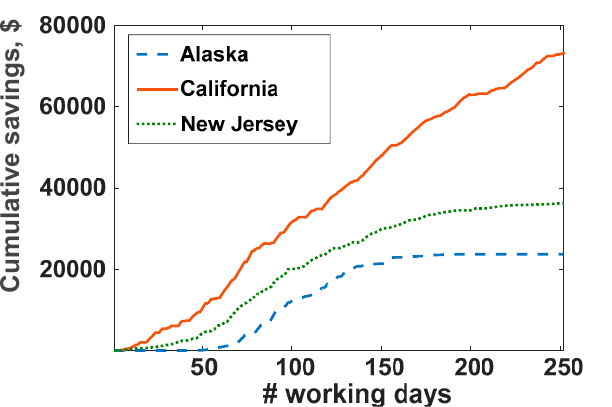
Figure 7 The original power balance profile and its change after different number of participating EVs. The curve 252 veh corresponds to the maximum total daily number of EVs awarded by a contract; the curve 150 veh is for illustration purposes to show the results of partial exploitation with less EVs than the prosumer needs to dispose its PV energy excess. In the case of no collaboration with EVs, the prosumer will at times have surplus solar generation that exceeds the consumption of the building. It was discussed in the Introduction that there is SRECs program [8] in the USA, but it requires participants to reserve a portion of their generation, therefore the daily amount of energy to supply the building consumption is reduced. For that reason, in the calculations in this paper for the chosen states, no value is assigned to the surplus solar generation in the case of no collaboration between prosumer and EVs. A quantitative comparison to state-of-the- art research on combining V2B with local PV generation is performed in Section 6.4.